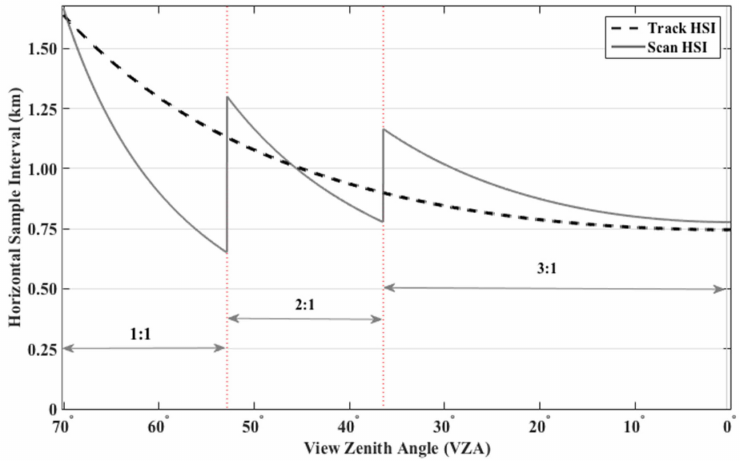
Figure 3. The sampling interval as a function of VZA, in along-track and along-scan